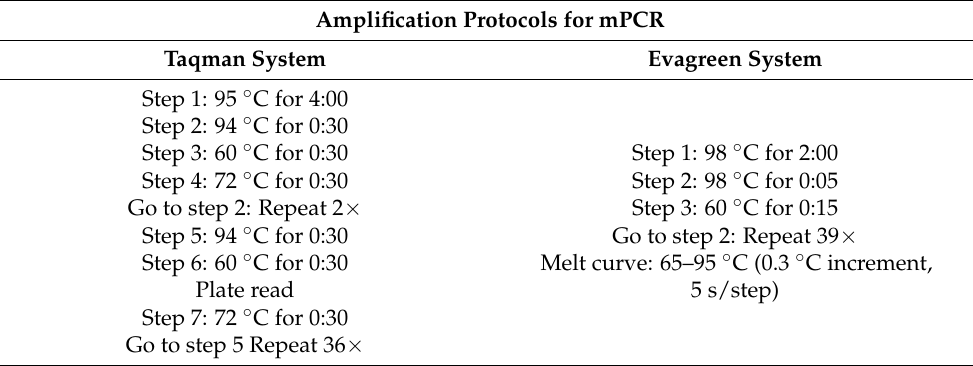
Table 4. Optimized protocols for quadruplex PCR with Taqman probes, and triplex PCR using